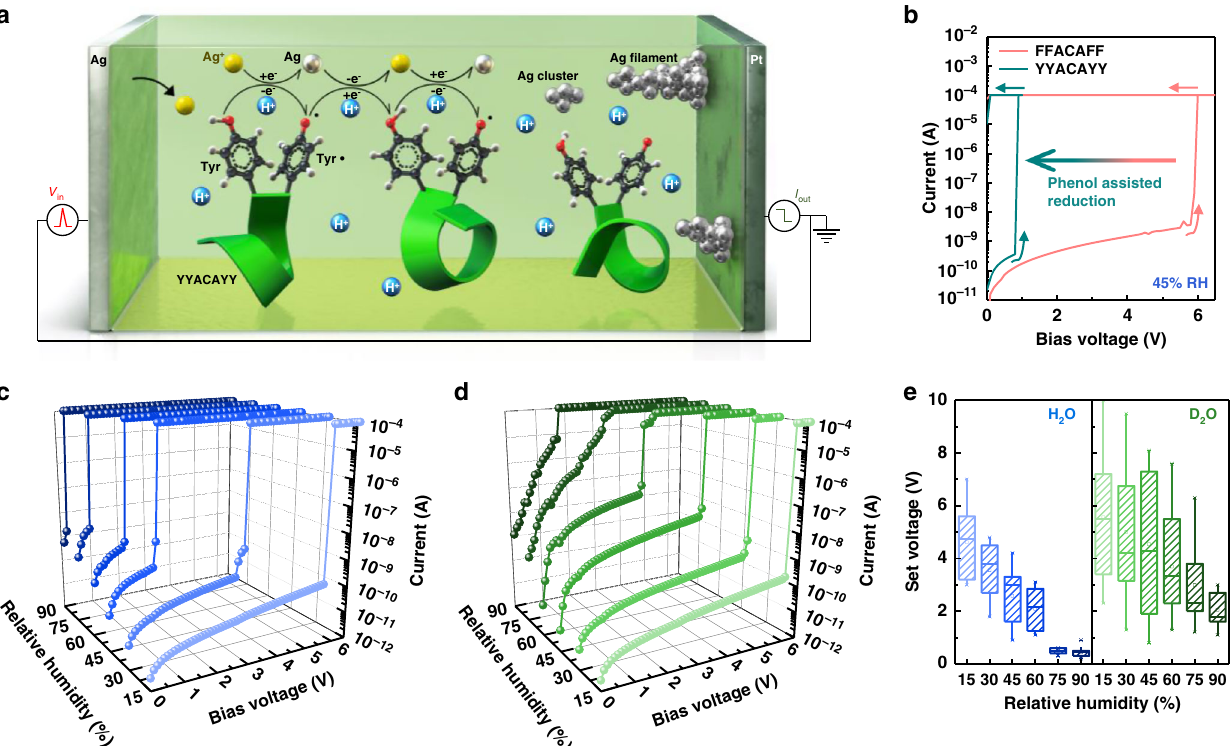
Fig. 2 Proton-mediated resistive switching characteristics of the Y7C peptide. ( a ) Schematic diagram of proton-mediated resistive switching of the Y7C fi lm. Helical peptide backbones are visualized as green ribbons. ( b ) Resistive switching characteristics of the Y7C peptide (emerald) and FFACAFF peptide (pink). Insets show the chemical structures of tyrosine and phenylalanine. ( c , d ) Resistive switching characteristics of Y7C under various relative humidities of H 2 O ( c ) and D 2 O ( d ) vapor. Increasing humidity is expressed in increasing darkness of colors. Each curve was measured after 2 h of fi xed RH conditions. ( e ) Statistical box plots of the set voltage of the Y7C fi lm as a function of the RH of H 2 O (left) and D 2 O (right). The interquartile range, mean, median, and outliers are represented by boxes, open squares, central lines, and whiskers,